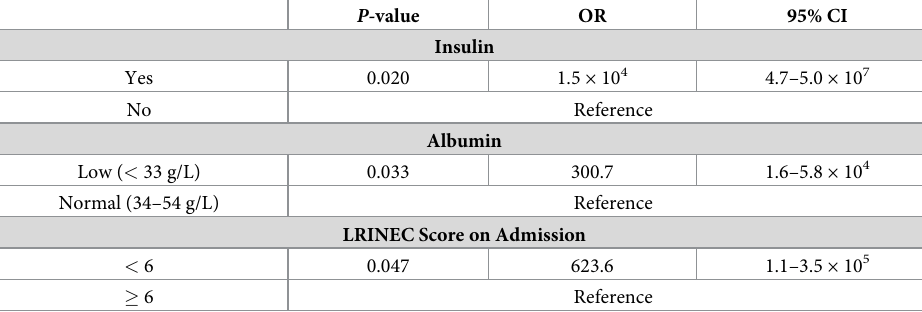
Abbreviations: LEA, lower extremity amputation; P, probability; OR, odds ratio; CI, confidence interval. The multivariate logistic regression analysis included all variables in Table 4 except comorbidities and length of stay